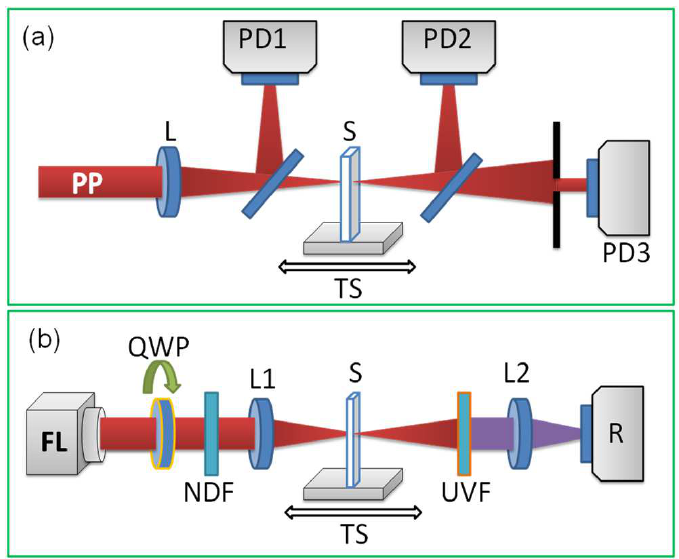
Figure 1. Experimental arrangements for the Z-scans and THG. ( a ) Z-scan scheme. PP, probe pulse (150 fs, 500–1700 nm); L, focusing lens; PD1–PD3, photodiodes (see text); S, sample (70-nm thick HgS QD film on the 0.15-mm thick glass slide); TS, translating stage. ( b ) Experimental setup for third-harmonic generation in thin films. FL: femtosecond laser (150 fs, 100 nJ, λ = 900–1700 nm, 500 kHz); QWP: quarter-wave plate; NDF: neutral density filters; L1: focusing lens; S: sample (thin film deposited on the 0.15 mm thick silica glass plate); TS: translating stage; UVF: ultraviolet filter; L2: collecting lens; R: registrar of third harmonic emission (spectrometer USB-2000, Ocean Optics, Ostfildern, Germany).